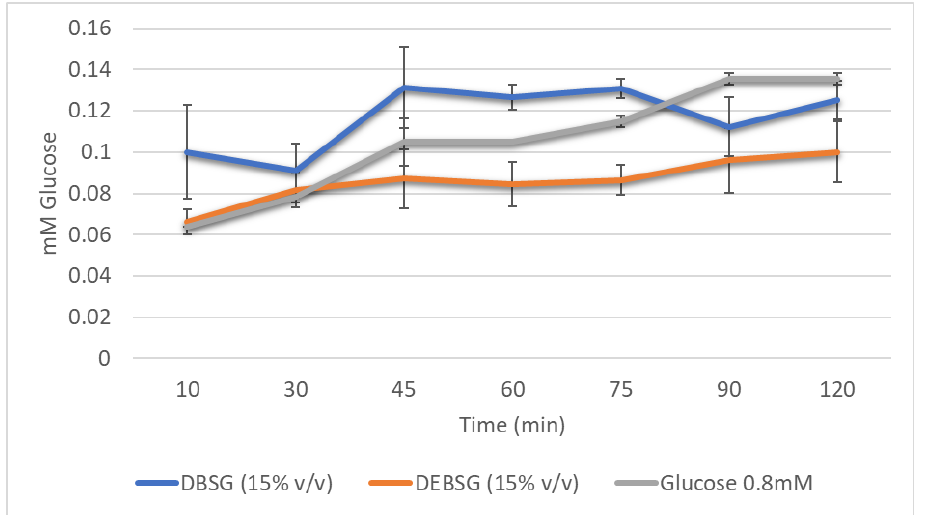
Figure 3. Brewers’ spent grain intestinal digests (DBSG) and extruded brewers’ spent grain intestinal digests (DEBSG) glucose absorption in IEC-6 cells over time .